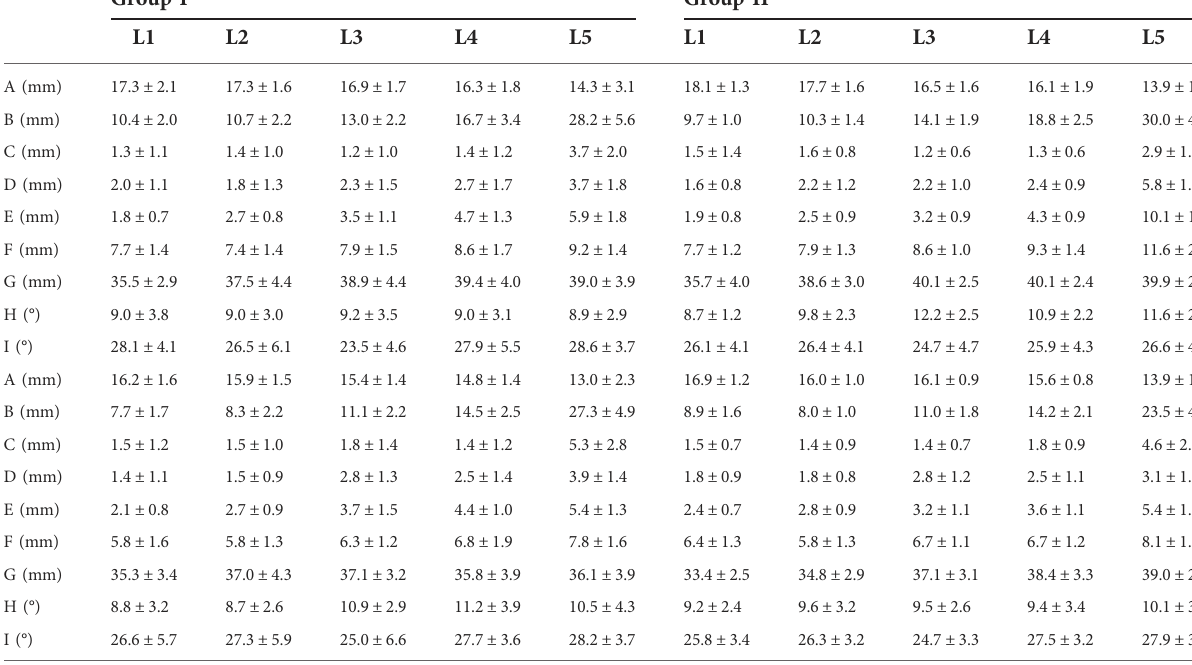
TABLE 1 Morphometric measurements of CBT pedicle screws